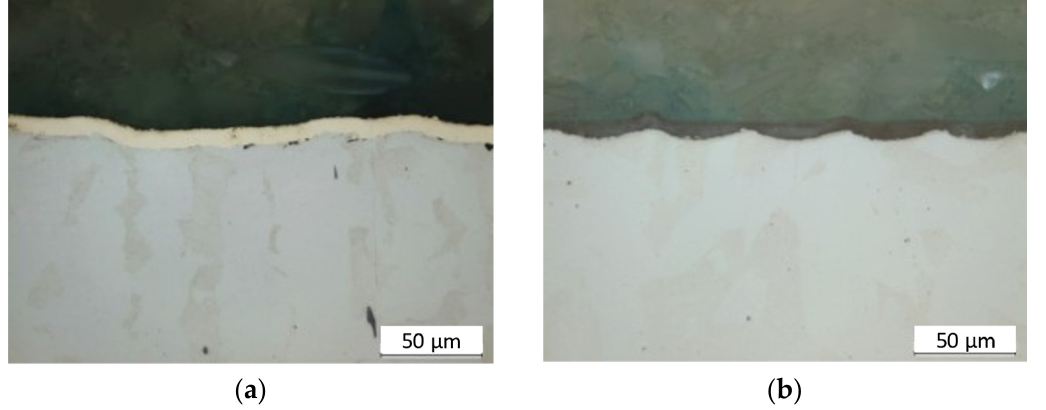
Figure 4. Optical micrographs for thickness measurements of ( a ) NI and ( b ) ZN conditions. Table 3. Roughness values ( 𝑅𝑎 ) of the disks and thickness values ( 𝑡 ) of the galvanizing treatments. Conditions